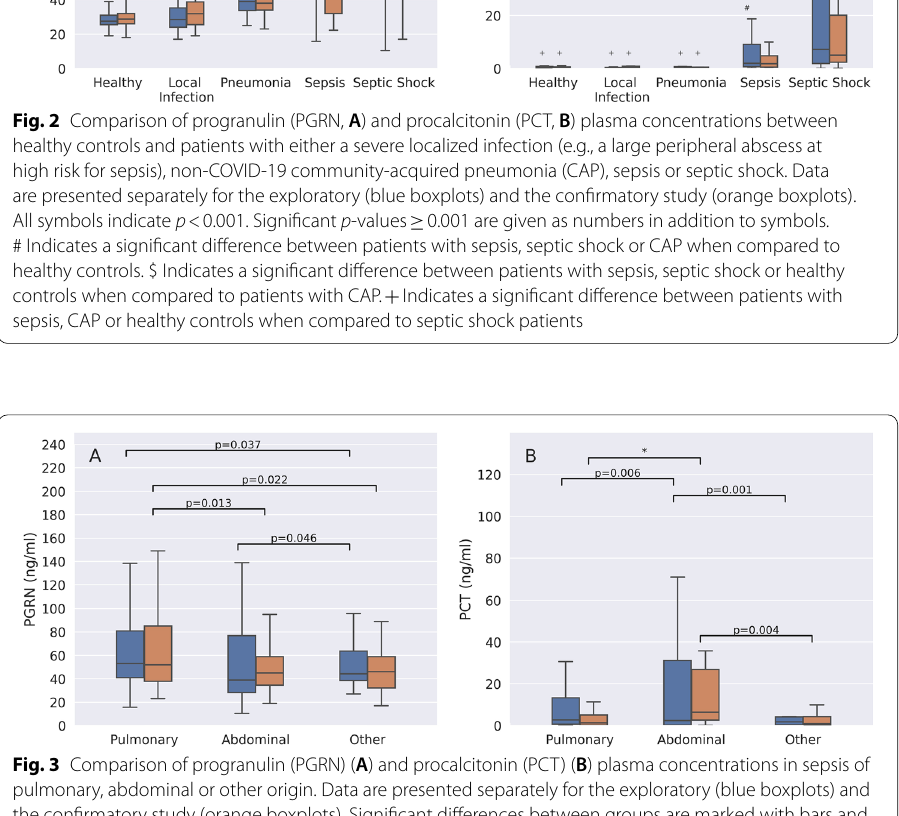
in plasma levels between patients with localized infections or non-COVID-19 CAP (Fig. 2B). Progranulin and procalcitonin plasma concentrations correlated significantly (Spearman’s rho 0.472, p 2.015E 11, n 181). = = − =